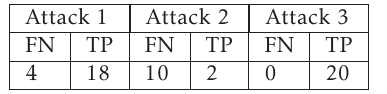
Table 7. Detection Performance Breakdown among